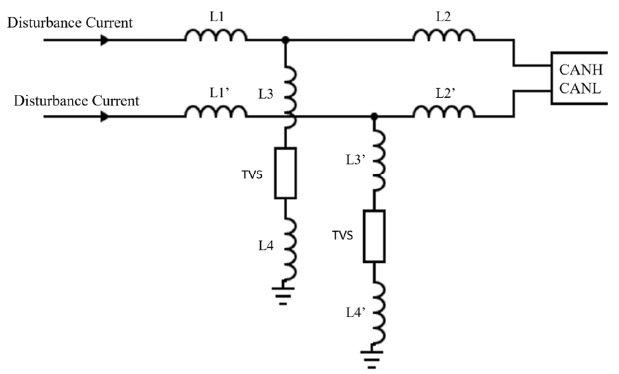
Figure 10. Parasitic inductances due to traces and VIAs between CAN data lines and ground. L3 and L4 should be as low as possible in order to minimize L ∙ dI/dt voltage amplitude.